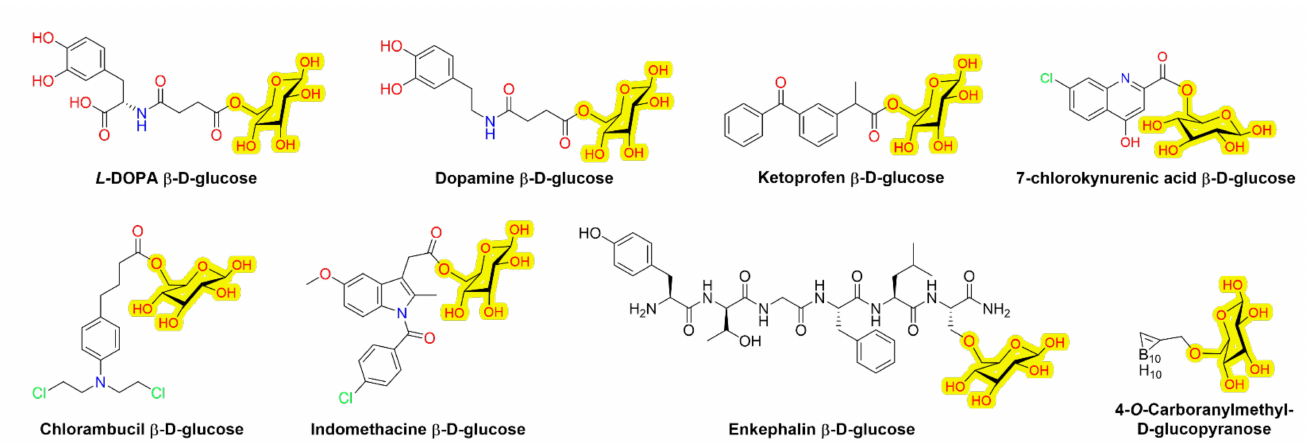
Figure 4. Molecular structures of GLUT1-utilizing prodrugs with promoieties highlighted with yellow